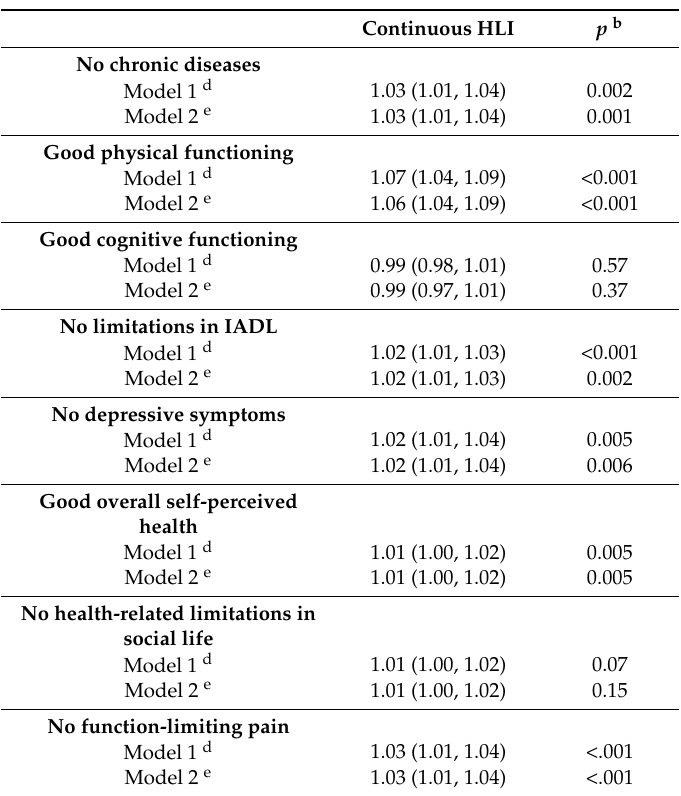
Table 3. HLI in relation to each component of healthy aging ( N = 2203) a